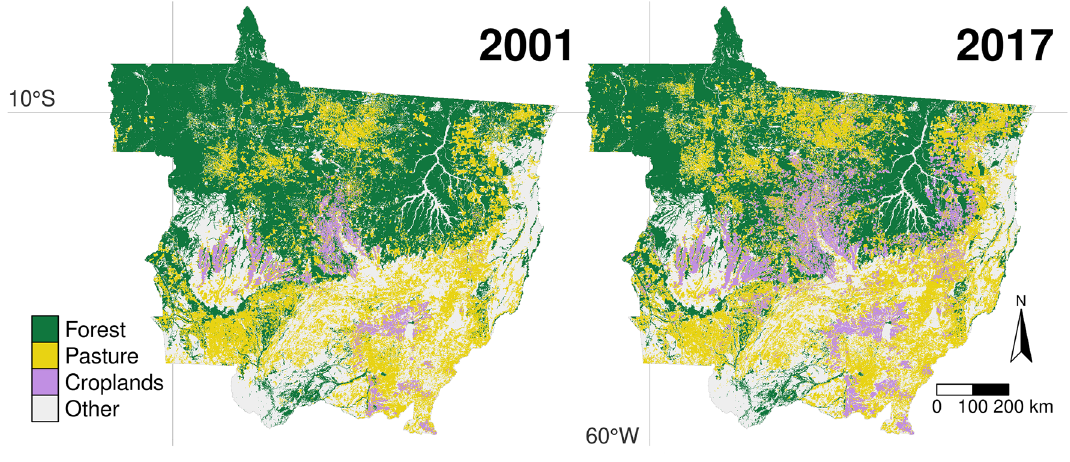
Figure 2. Land use cover in Mato Grosso in 2001 and 2017. The clustered expansion of croplands and their appearance in areas previously covered by forest or pasture is noticeable when comparing both years. The area devoted to pasture has also increased considerably, replacing vast amounts of forest. See Fig. 3 for a visualisation of transitions between land use cover. Data is derived from the maps by Câmara et al. 40 ; created using the tmap